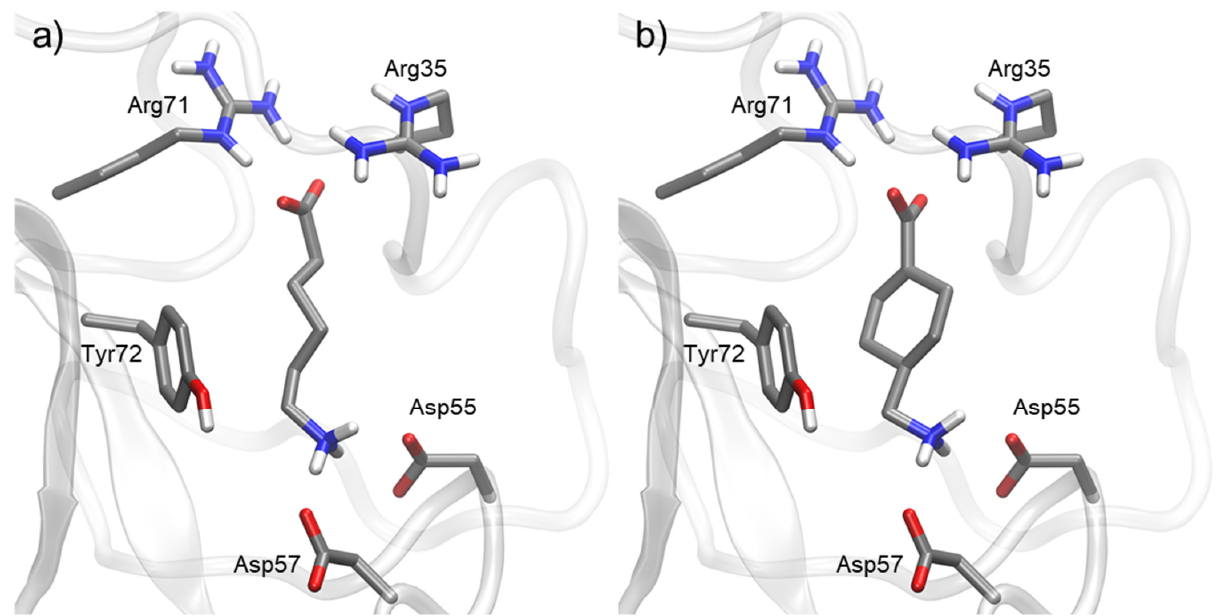
Figure 4. Docking of most representative poses for lysine analogues ( a ) ε -aminocaproic acid (EACA) and ( b ) tranexamic acid (TXA). Docking studies were performed with Kringle 1 lysine binding site (pdb code 1cea) using AutoDock 4.2.